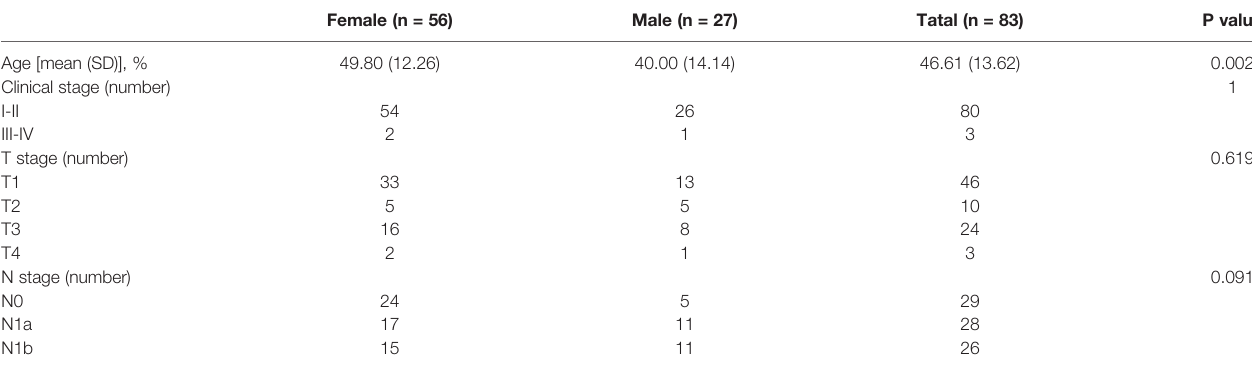
TABLE 1 | Demographics for the 83 Chinese patients with PTC in this